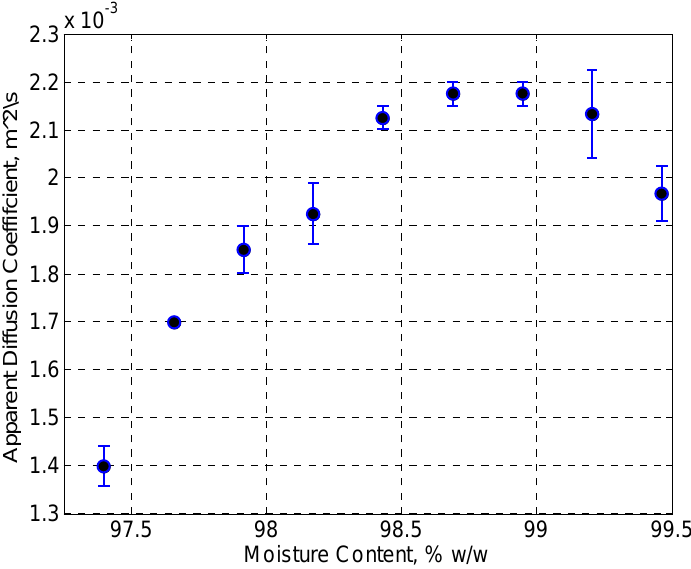
Figure 2. MRI measured proton diffusion coefficient as a function of moisture